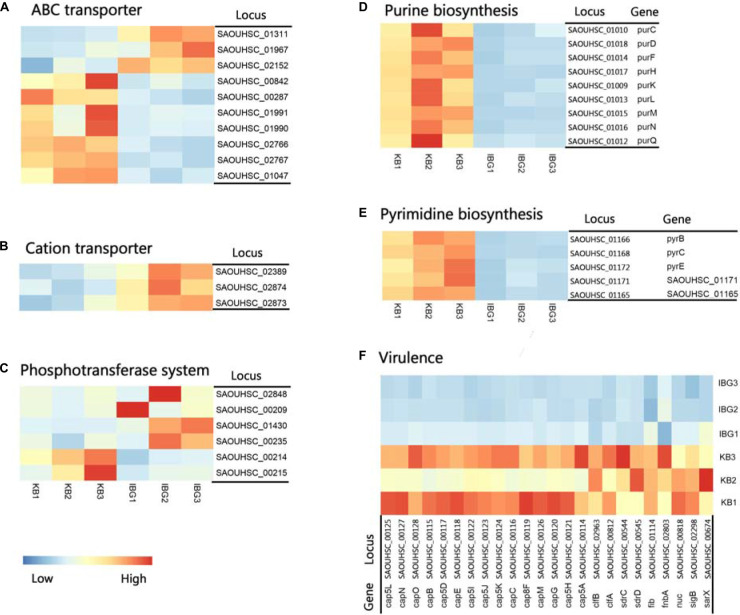
Heat map representation of DEGs involved in main pathways. (A) DEGs related to ABC transporters. (B) DEGs involved in cation transporters; (C) DEGs related to phosphotransferase system. (D) DEGs involved in purine biosynthesis pathway. (E) DEGs involved in pyrimidine biosynthesis pathway. (F) DEGs involved in virulence. All genes represented have a >twofold change in expression treated with IBG relative to their expression in control samples.